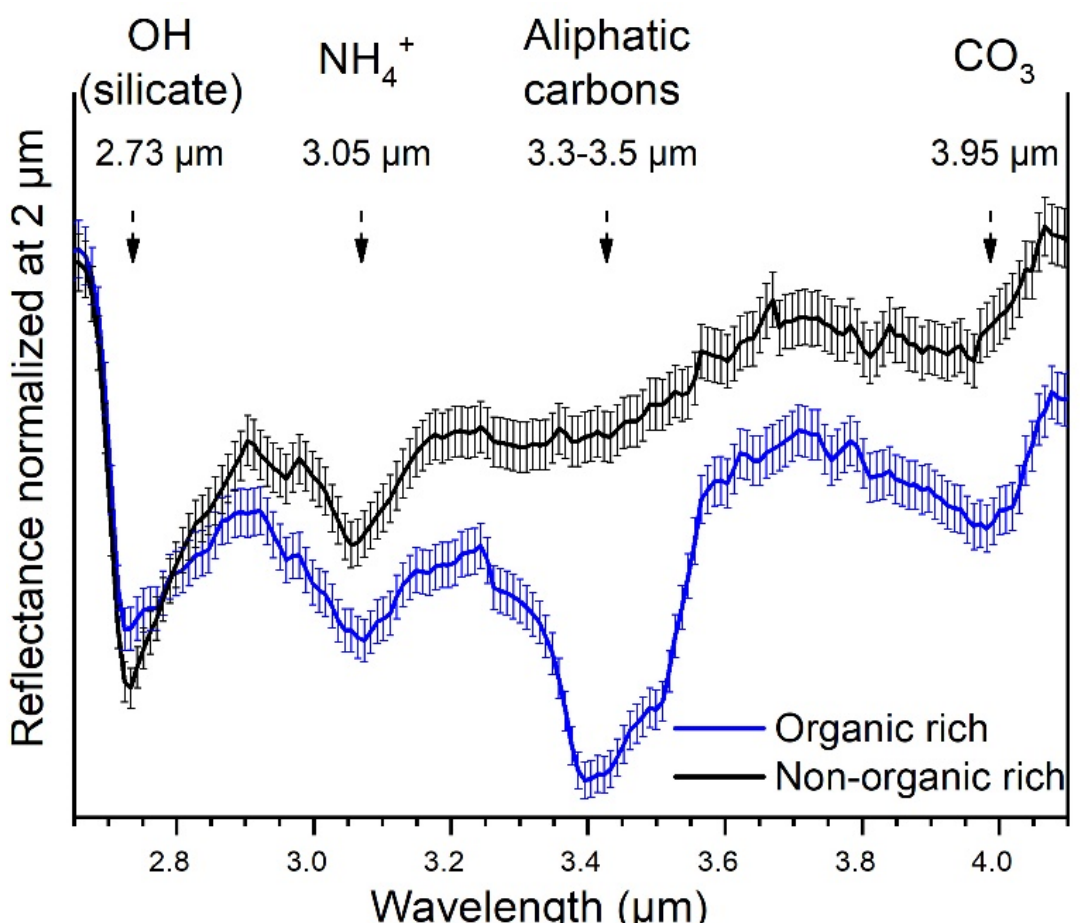
Figure 1. Spectra of organic-rich areas (2 km²—blue line) compared with non-organic-rich areas (6 km²—100 km southeast of Ernutet crater—black line).